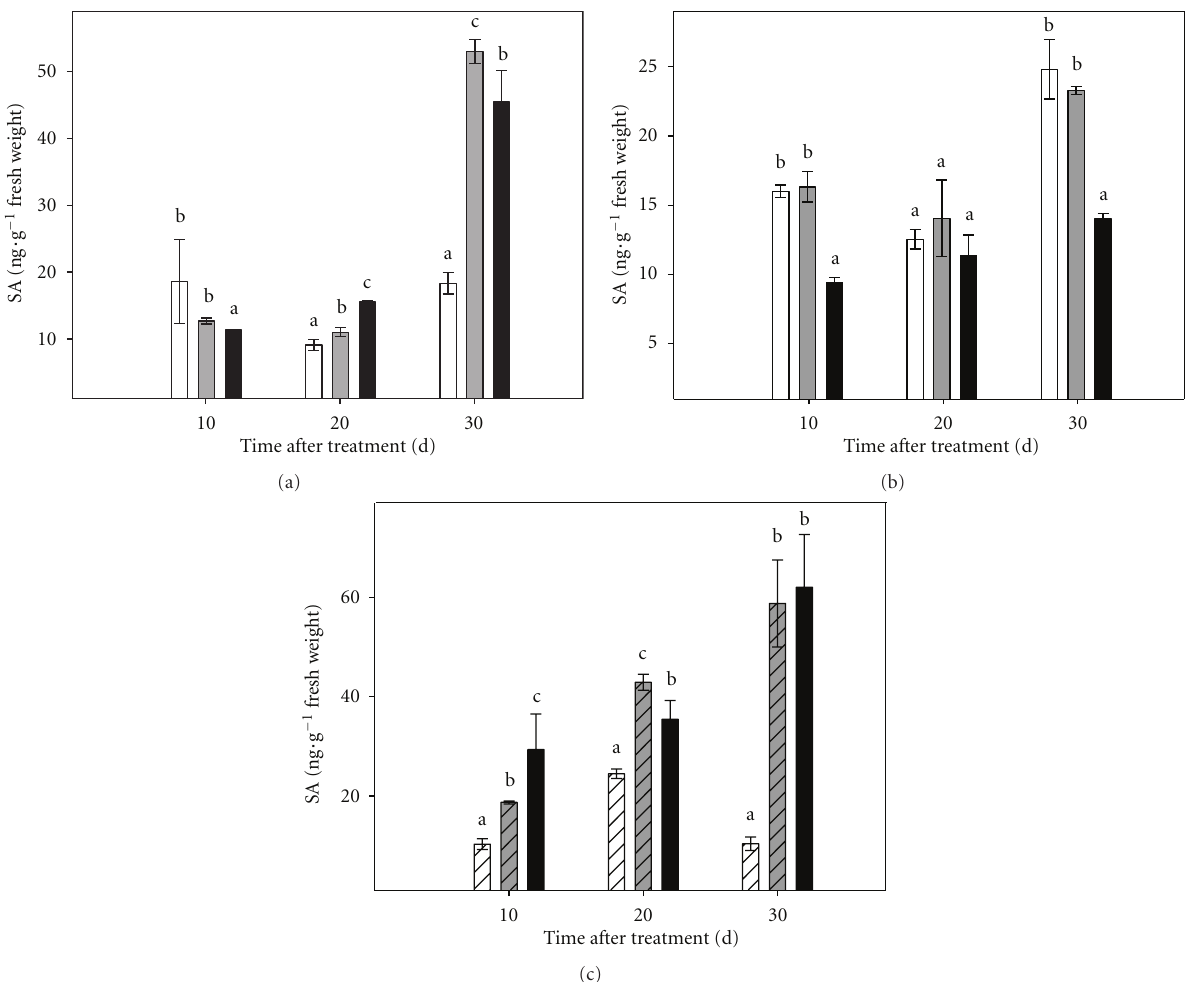
Figure 9: E ff ect of osmotic stress on SA content in Carrizo citrange plants cultured in vitro . (a): aerial part of intact plants; (b): root tissue of intact plants; (c): micropropagated shoots. Control plants (white bar), plants cultured under moderate (grey bar) or severe (black bar) osmotic stress conditions. Each point corresponds to the average ± standard error of six independent determinations. Di ff erent letters denote statistical significance at P <